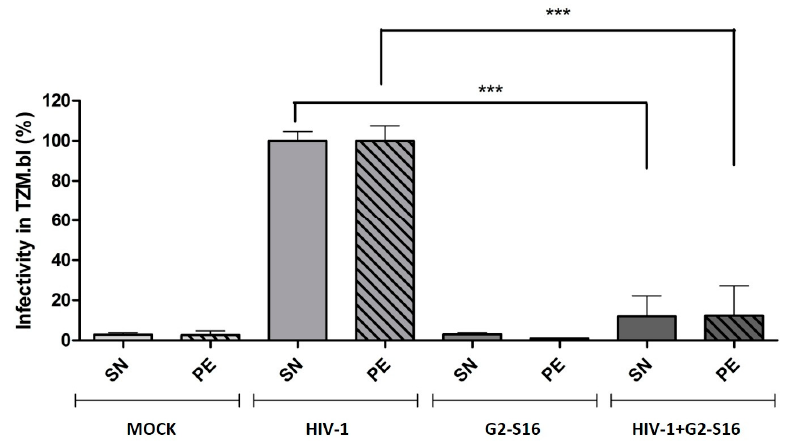
Figure 2. G2-S16 inhibits HIV-1 inside MDMs. Human monocytes were isolated and differentiated to MDMs, after differentiation cells were treated for 2 h with G2-S16 dendrimer, washed with glycine (pH 3) to detach non-internalized dendrimer, and washed with PBS. MDMs were then infected with 6 ng/µL of HIV-1 per 1 × 10 6 cells for 2 h, inoculum was discarded, and cells incubated at 37 °C for 3 days. Supernatants and cell pellets were separated by centrifugation and titrated by TZM.bl infection. Mock cells were used as non-treated control. The mean values (mean ± SD) of three independent experiments are shown (*** p < 0.001).